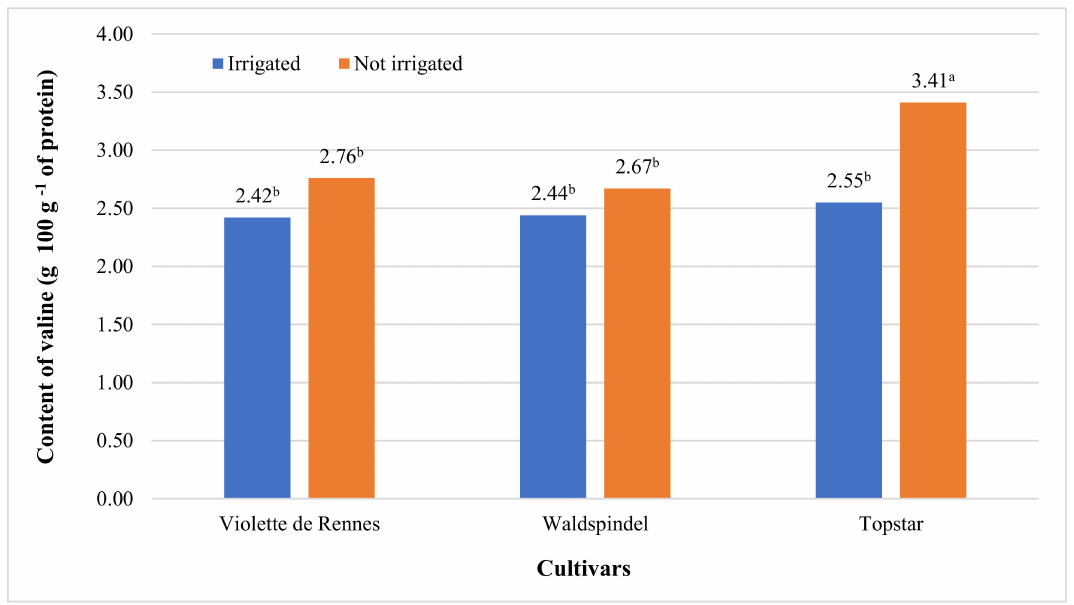
Figure 5. The e ff ect of irrigation on the valine content of tubers in the analyzed Jerusalem artichoke cultivars. Means with the same letters do not di ff er significantly at p ≤ 0.05 in Tukey’s test. The absence of letters denotes non-significant main e ff ects.